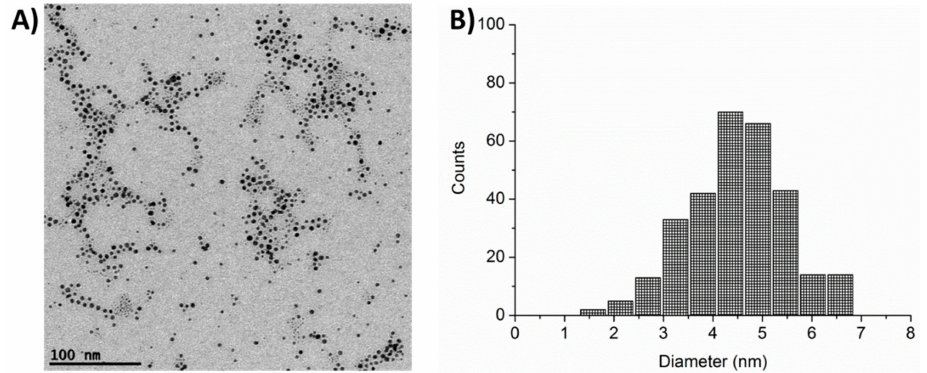
Figure 2. TEM characterization of non-functionalized AuNPs. ( A ) Representative TEM image of AuNPs. ( B ) Statistical distribution of AuNP particle